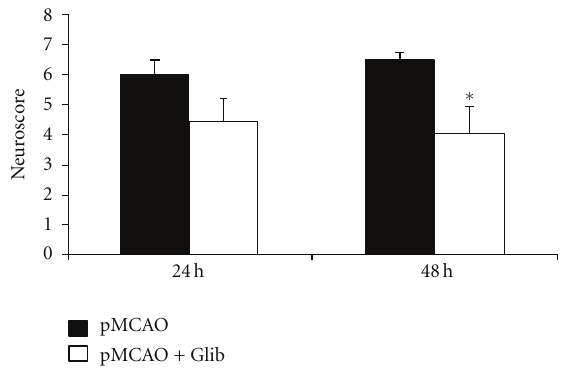
Figure 3: Glib improves neurological functions in a rat model of pMCAO. Treatments with Glib significantly decreased the NSS compared to the vehicle-treated group at 48 h after occlusion. P < 0.05; ∗ significant di ff erence compared to MCAO + Vehicle. Values are expressed as mean ± SE.